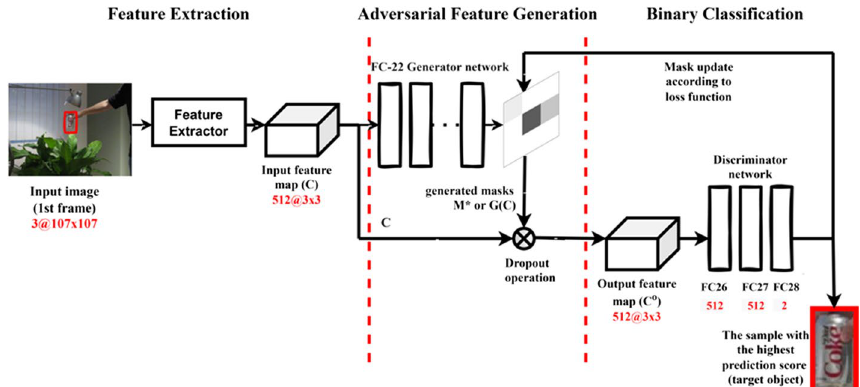
Fig. 3 The architecture of RTDG tracking framework which uses 22‑FC generative model in the training